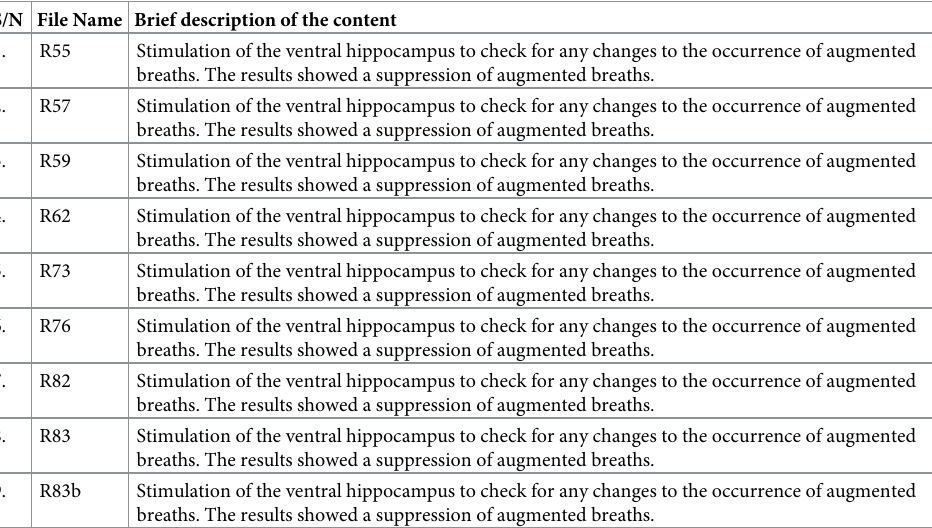
Table 1. Raw tracing Data files represents experiments for the neurochemical microstimulation of the ventral hippocampus (n = 8). Each file was from a separate animal with the exception of R83 and R83b where there was a soft- ware glitch that caused us to restart the software. Hence the reason for the